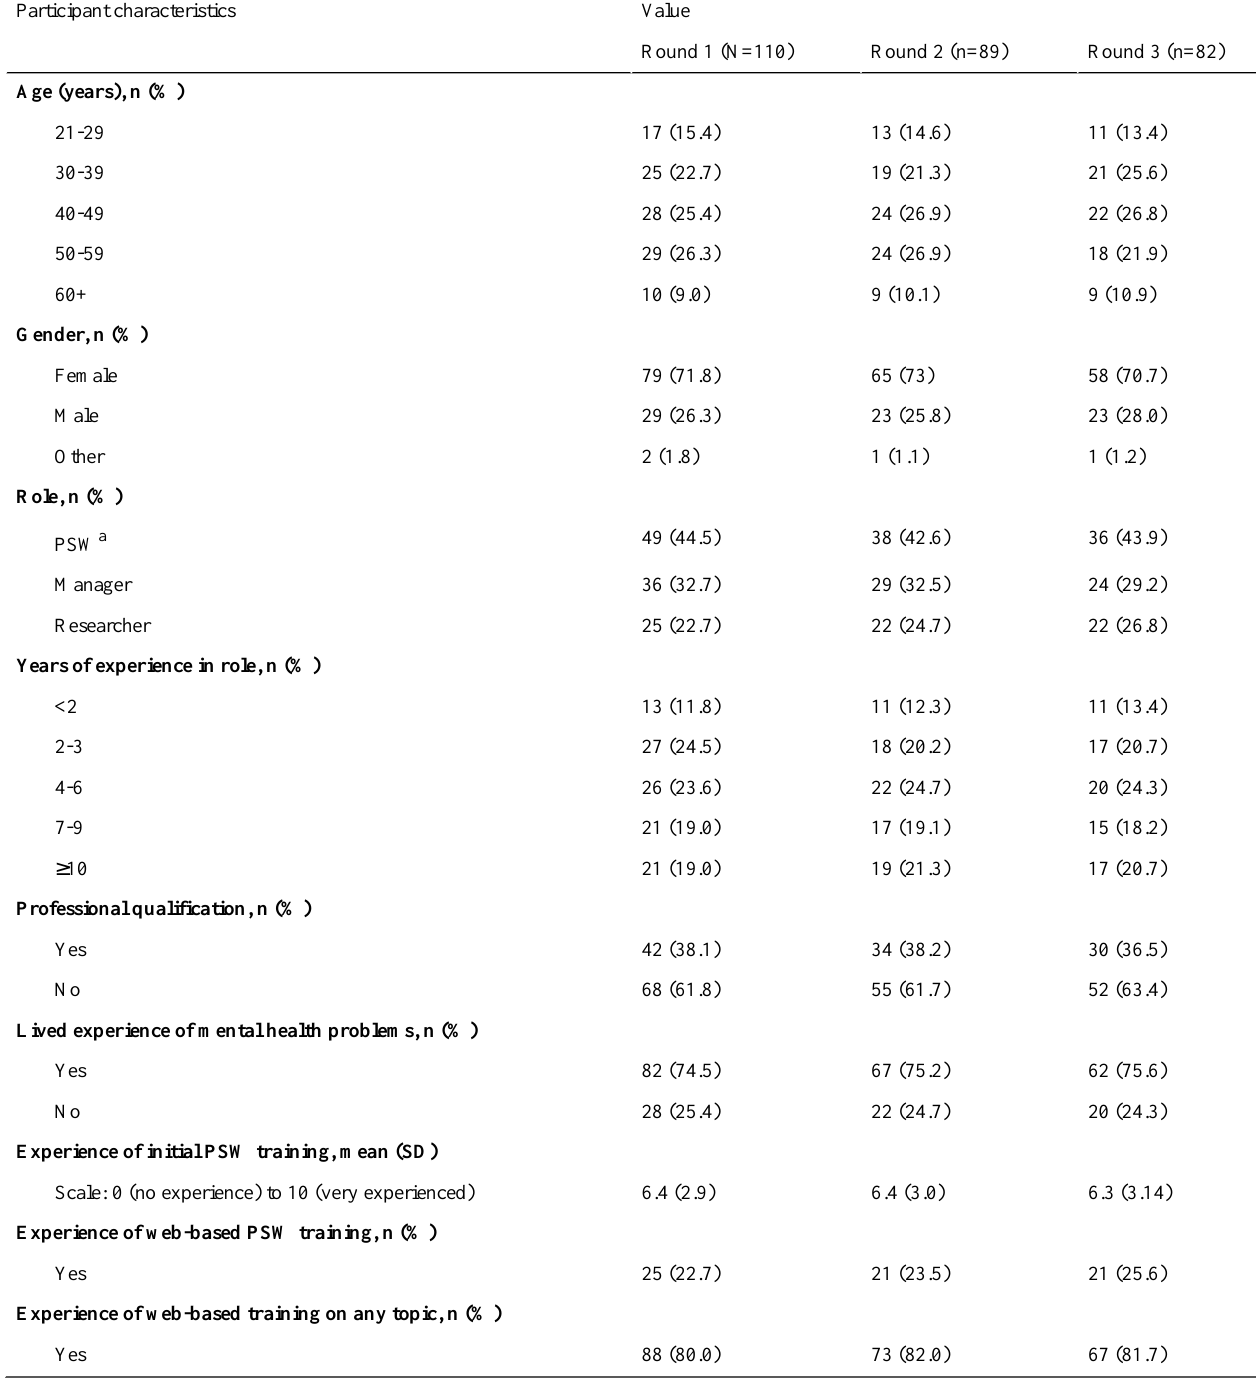
Table 1. Characteristics of the Delphi consultation participants (N=110). ValueParticipant